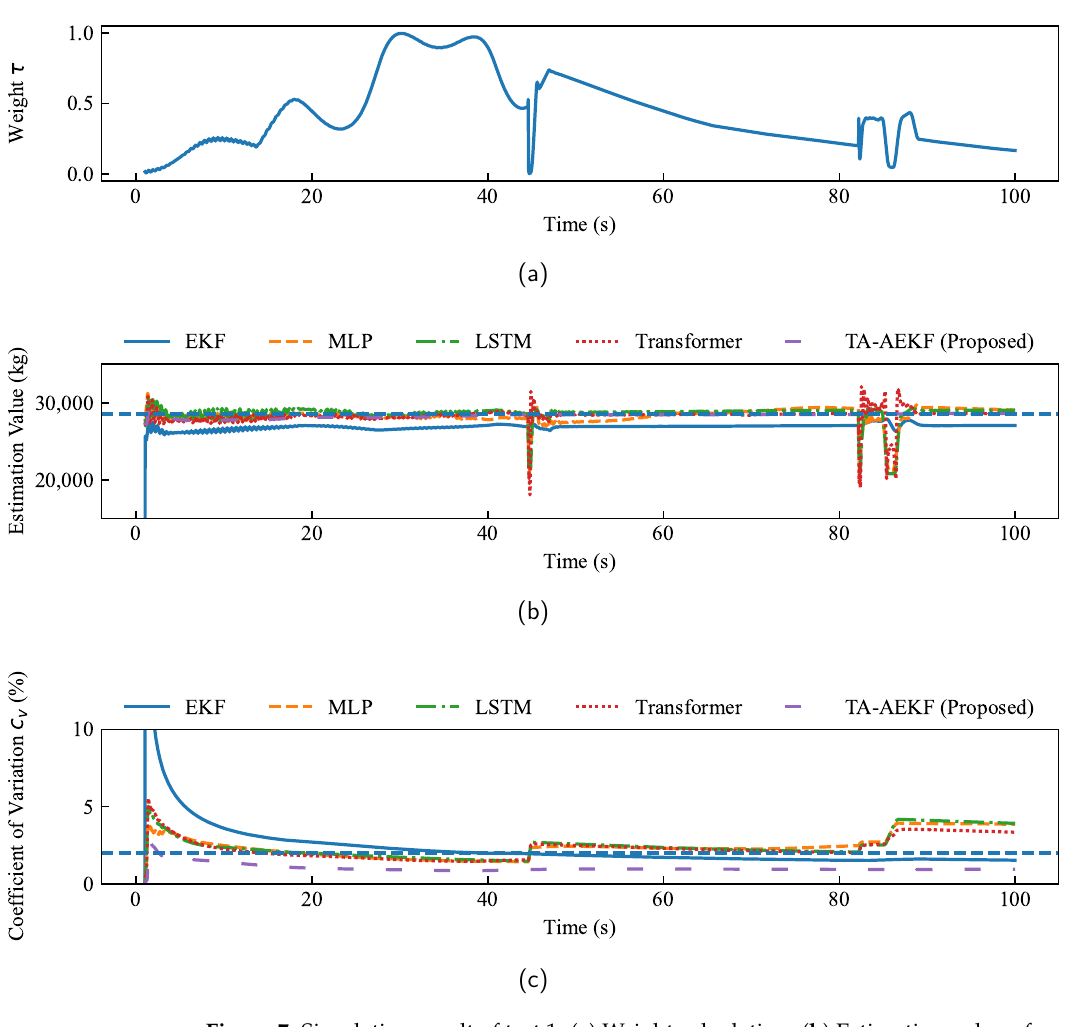
Figure 7. Simulation result of test 1: ( a ) Weight calculation. ( b ) Estimation value of mass. The blue dashed line represents the result of the ground truth. ( c ) Evaluation with c v . The blue dashed line represents c v 0 =